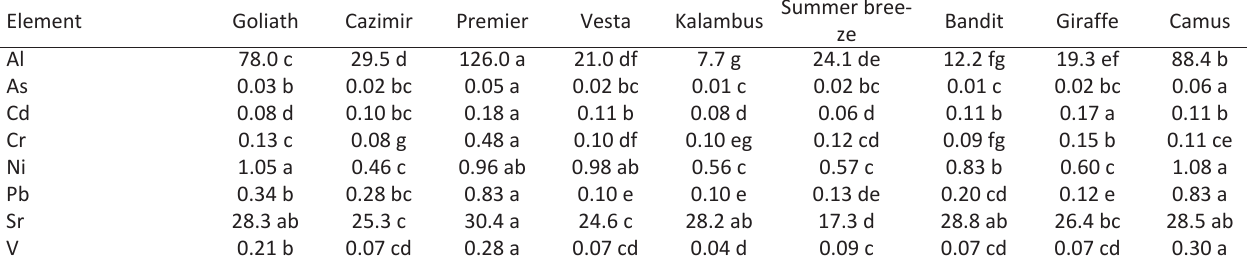
Within each row, means followed by different letters are significantly different according to Duncan test at